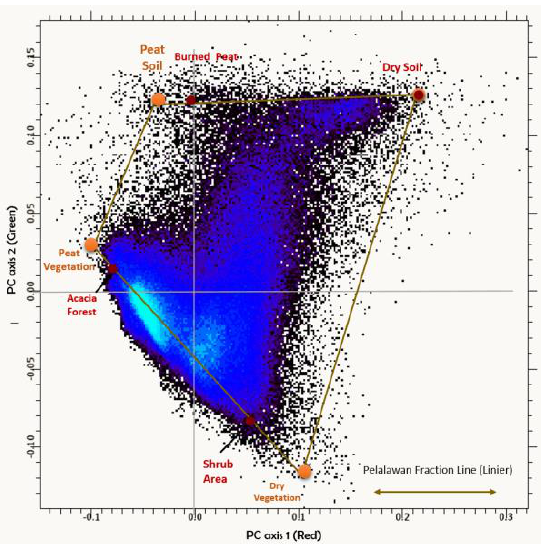
Figure 7. Scatterplot of endmember spectra in based on Pelalawan Fraction Line.